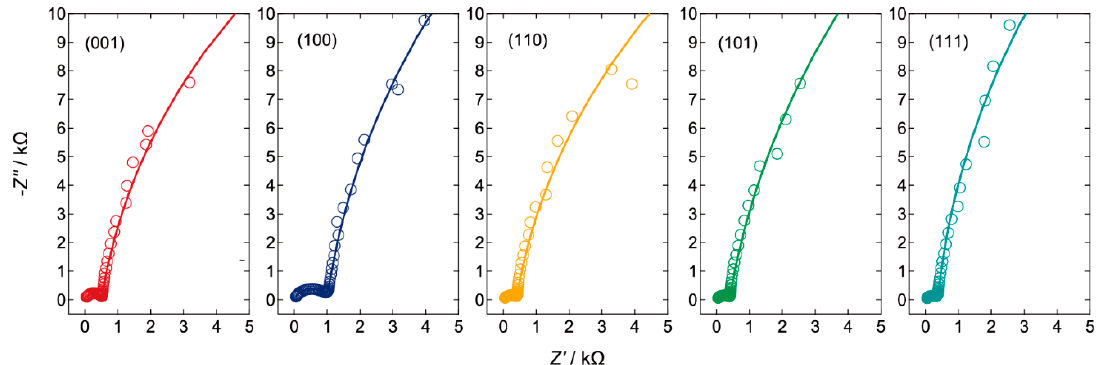
Figure 10. The Nyquist diagrams of TiO 2 :Nb single-crystal substrates with the (001), (100), (110), (101), and (111) crystal-plane surface measured at 1.5 V RHE under 1 sun illumination. Table 2. Fitted parameters of the Nyquist plots for single-crystal TiO 2 :Nb photoanodes. LATTICE PLANE